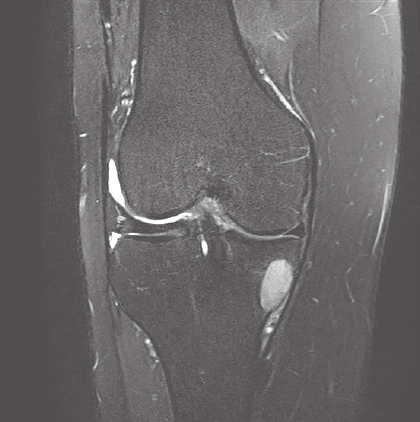
Figure 5: T2 weighted fat suppressed MRI in coronal plane shows well circumscribed hyperintense lesion in the medial tibial plateau without surrounding marrow edema. No communication of the lesion with tibial tunnel was present.